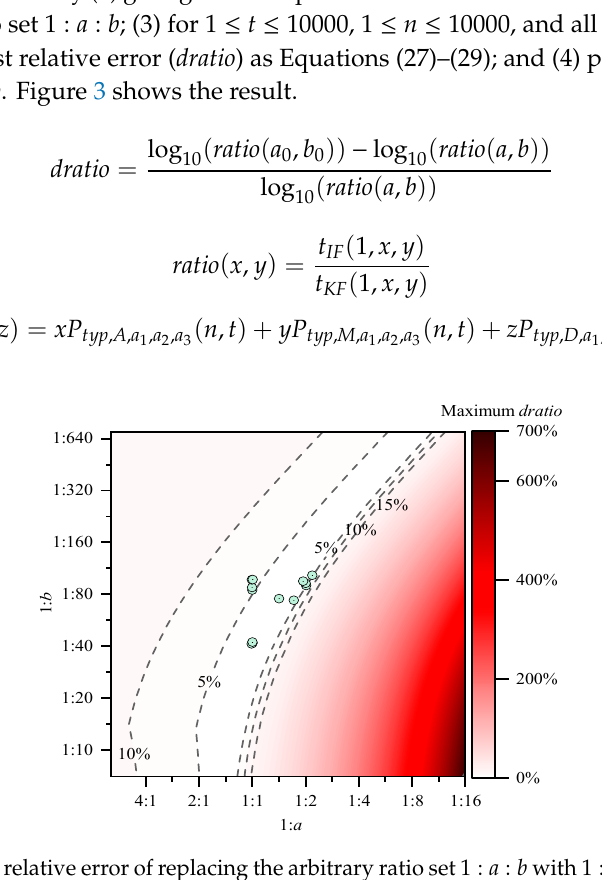
Figure 3. Maximum relative error of replacing the arbitrary ratio set 1 : a : b with 1 : a 0 : b 0 = 1 : 1.6 :